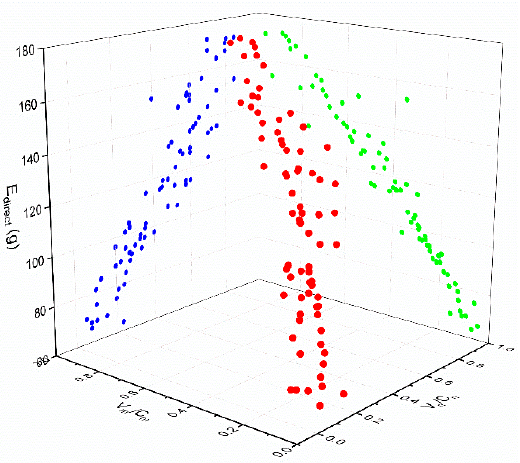
Figure 6. Relationship between direct carbon emissions and road saturation in scenario B1.